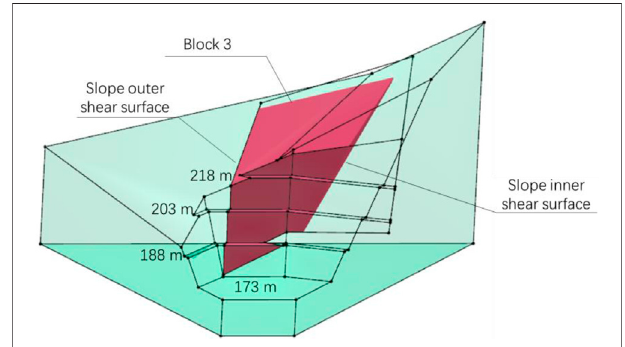
FIGURE 9 | Semilocating the block on the upstream slope of the dam abutment (block 3).